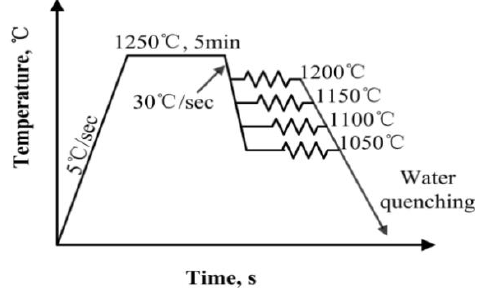
Figure 1. Schematic diagrams of the hot compression test.